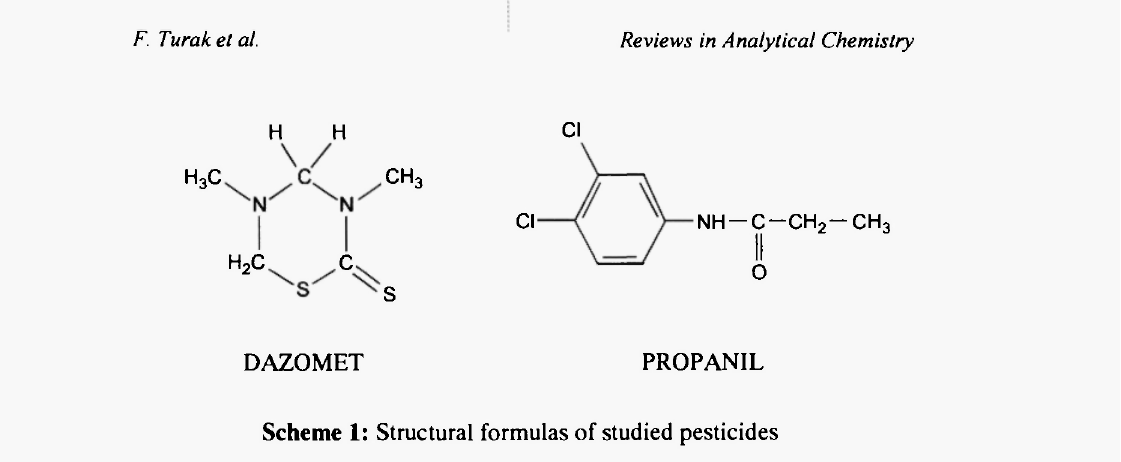
Scheme 1: Structural formulas of studied